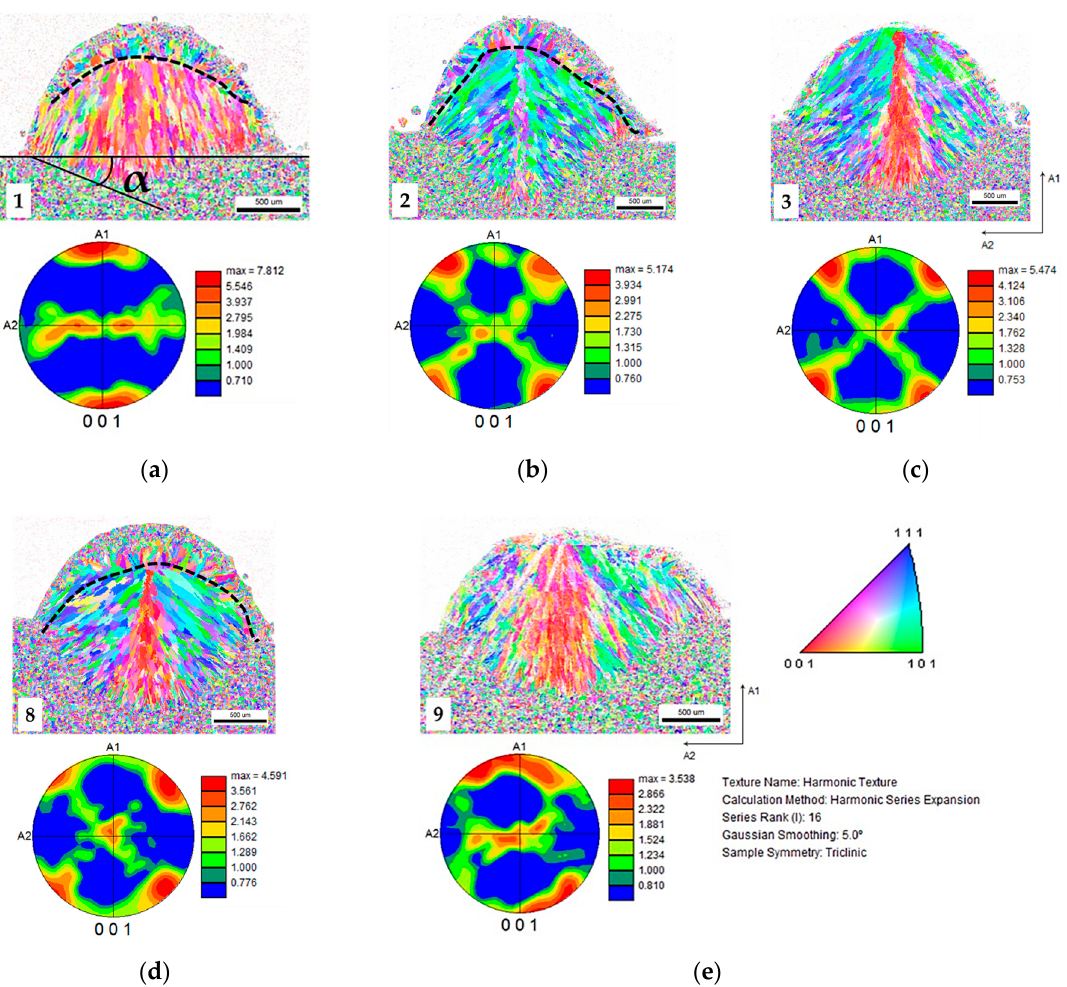
Figure 7. (100) IPFs (above) showing grain orientation along growth direction and respective pole figures (below) for process parameter conditions as in Table 2. The dotted line in ( a , b , d ) indicate columnar to equiaxed transition (CET), which is confined to a very small region in ( c , e ). α depicts the interaction angle made by the deposit with the substrate.